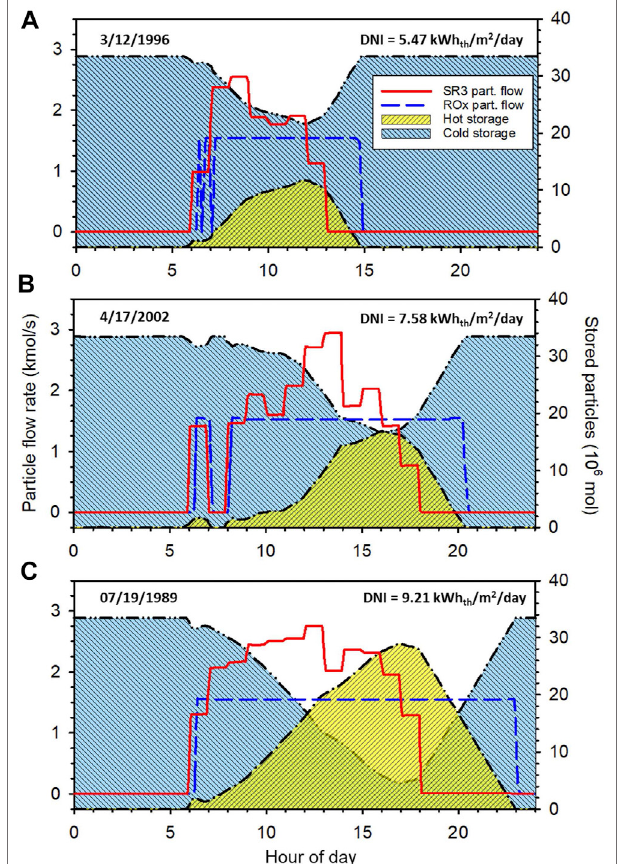
FIGURE 3 | Intraday dispatch schedule using seasonally representative DNI data from tmy3. (A) , winter (B) , spring and fall, and (C) summer.